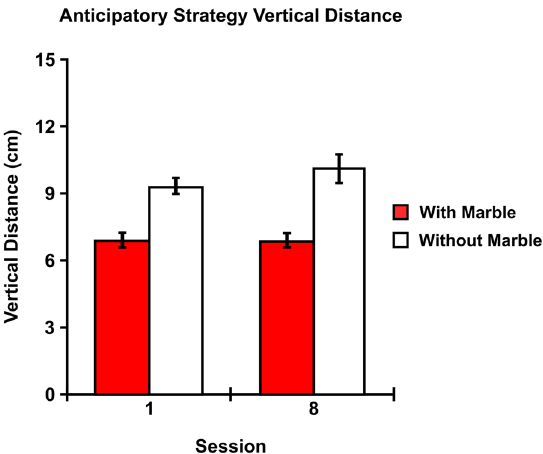
Figure 6. Anticipatory Strategy Vertical Distance – The average vertical distance for anticipatory strategies occurring without the marble was greater than anticipatory strategies occurring while transporting the marble. Error bars indicate SEM. N =